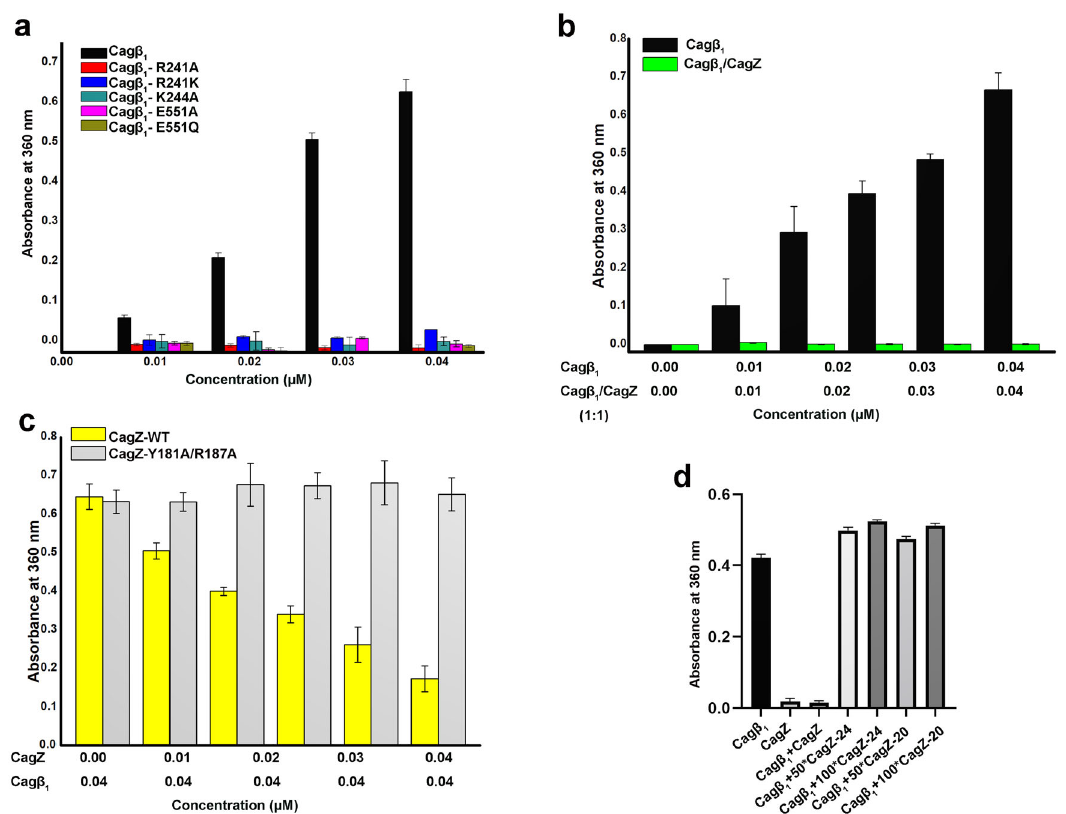
Fig. 6 | ATPase activity assays of Cag β 1 . a ATPase activity of apo-Cag β 1 wild type and ATP binding site mutants measured by a photometric assay (see details in methods). b CagZ inhibits the ATPase activity of Cag β 1 . c the Y181A/R187A muta- tions of CagZ, which disrupt the interaction with Cag β 1 , abolish the inhibition on